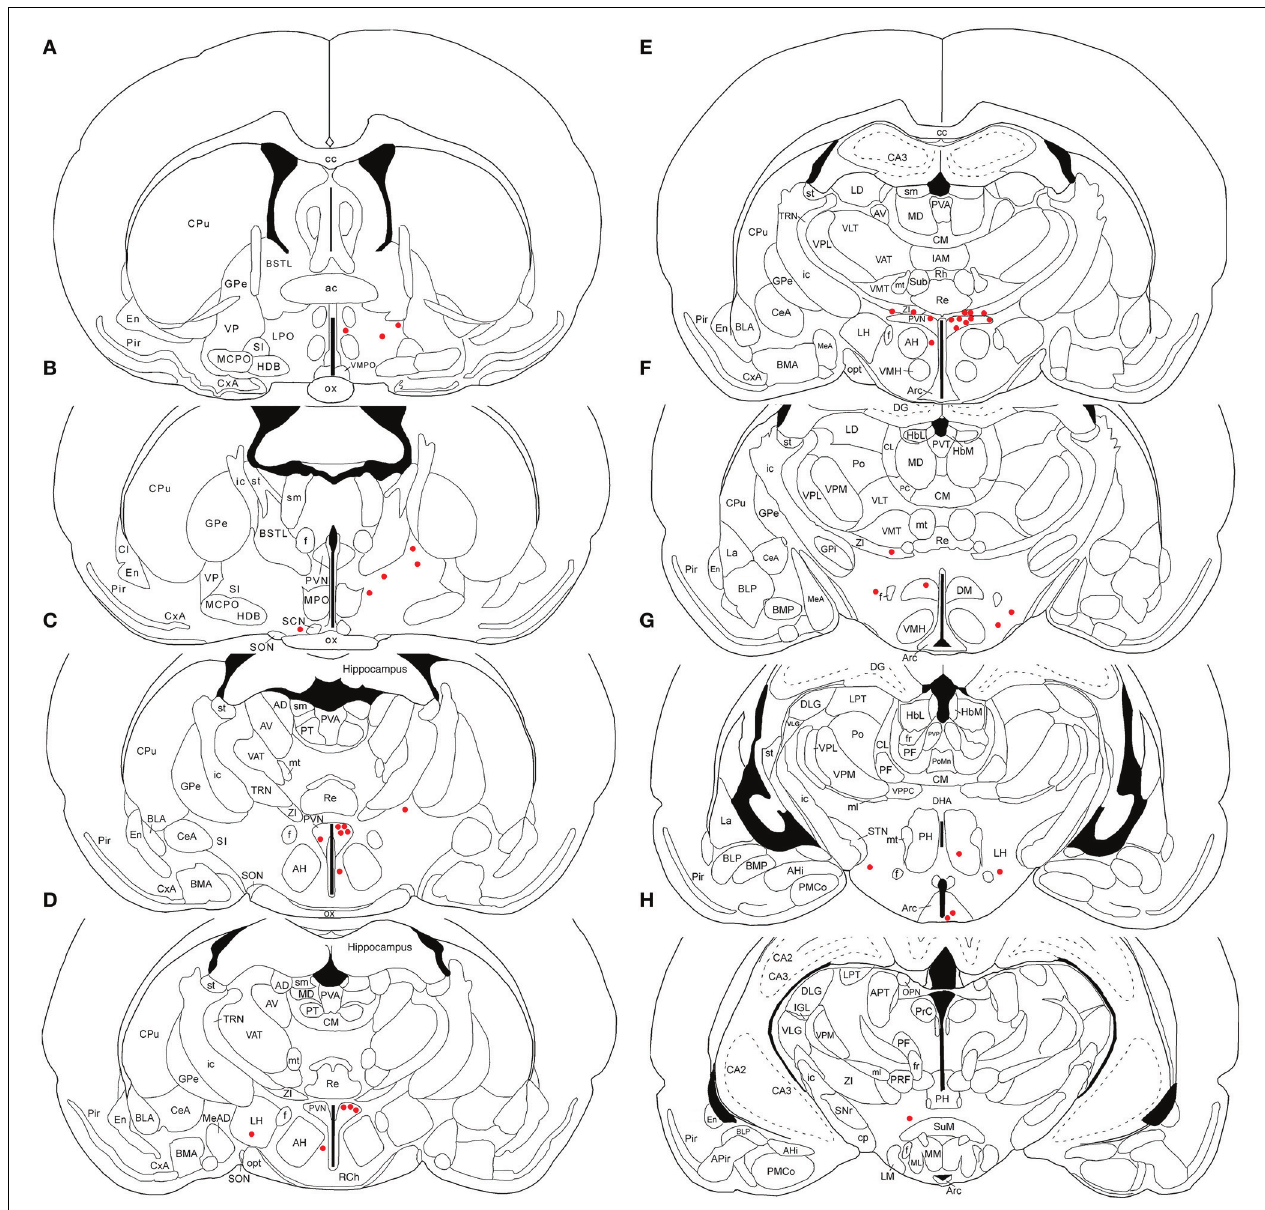
PRV + neurons in RF73. Each filled red circle represents one PRV + neuron. The images progress from most rostral at the top left (A) to most caudal at the lower right (H) . For full structure names see list of